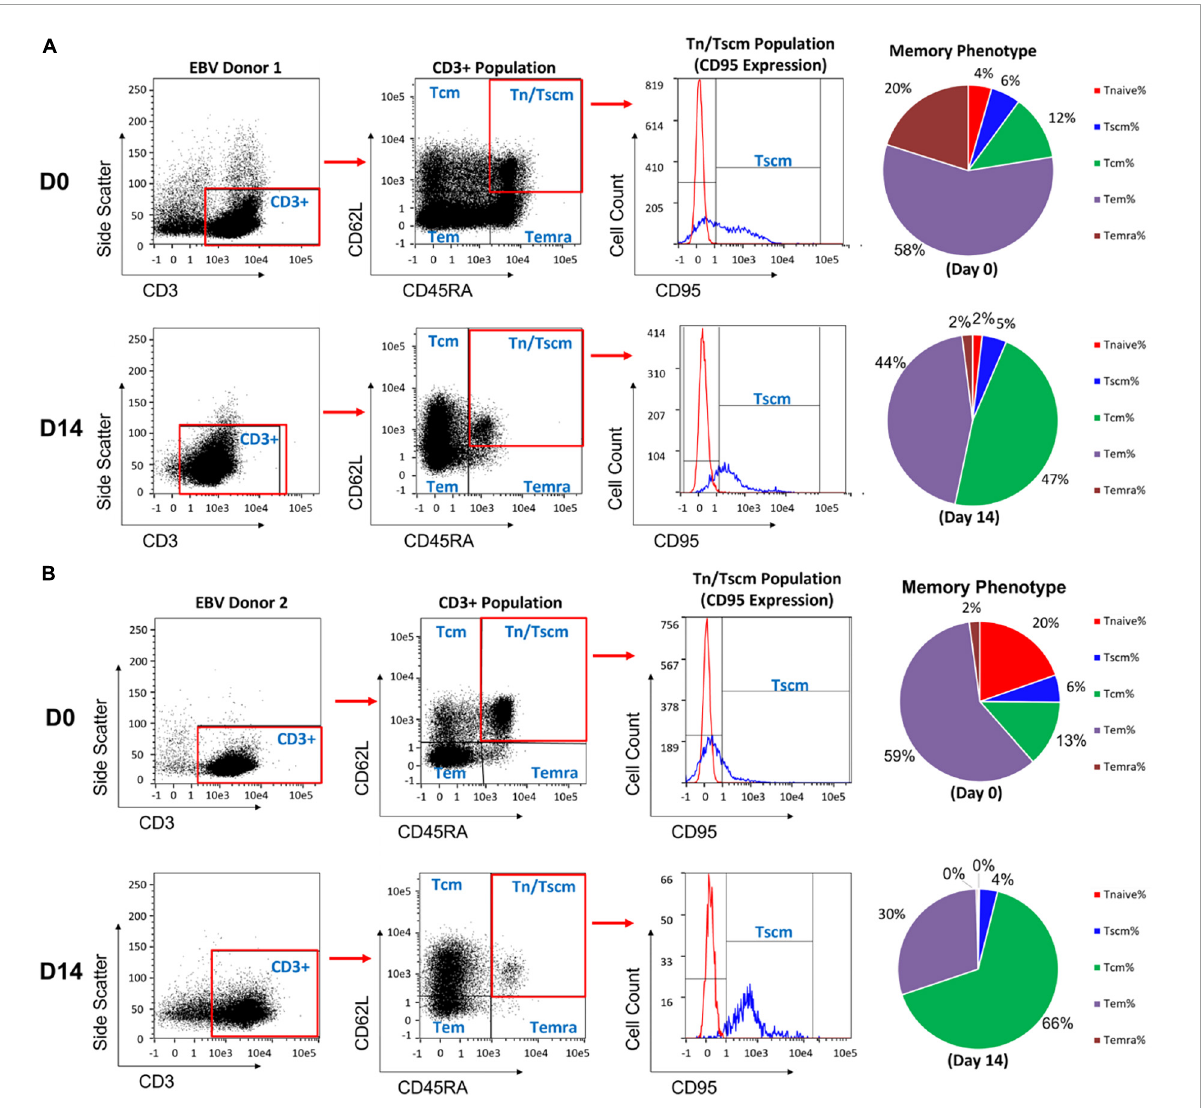
FIGURE3 Phenotype of the T cells on day 0, before expansion, and on day 14 after enrichment and expansion for EBV antigen specific T cells using the AIM ACT system. (A,B) Results are shown from two healthy donors. After completion of expansion, T cells from each run were taken for phenotyping memory cell populations by staining for CD62L vs CD45RA. The naïve and stem cell-like memory cells were further distinguished by CD95 expression. The pie charts show the distribution of memory T cell subsets at day 0 and day 14 of the process. Central memory T cells (Tcm), effector memory T cells (Tem), effector memory T cells re-expressing CD45RA (Temra), stem cell-like memory T cells (Tscm), naïve T cell